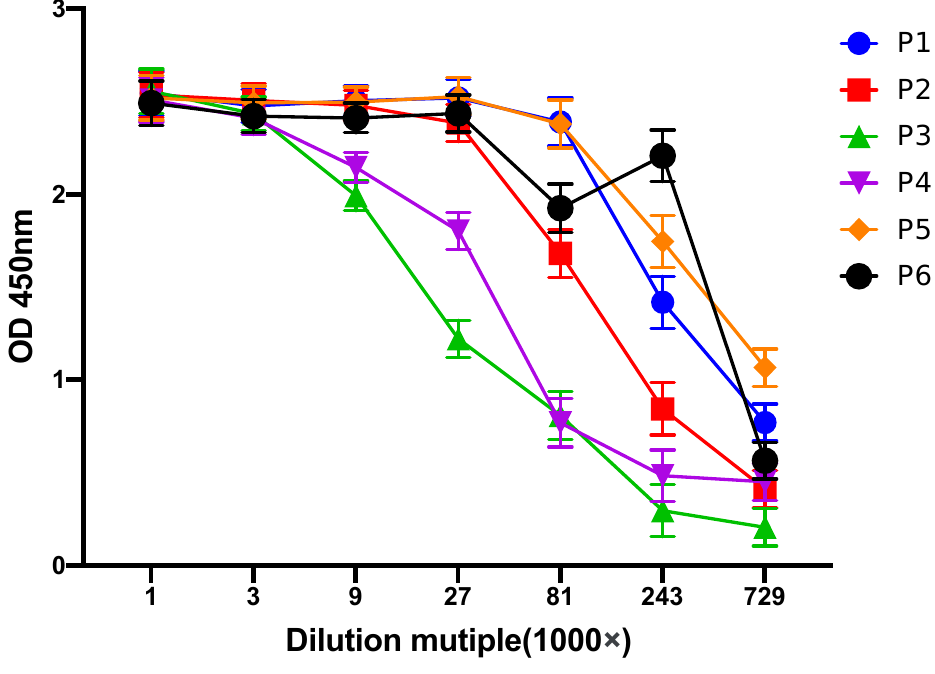
Figure 1. Titers of monoclonal antibodies against PPI.